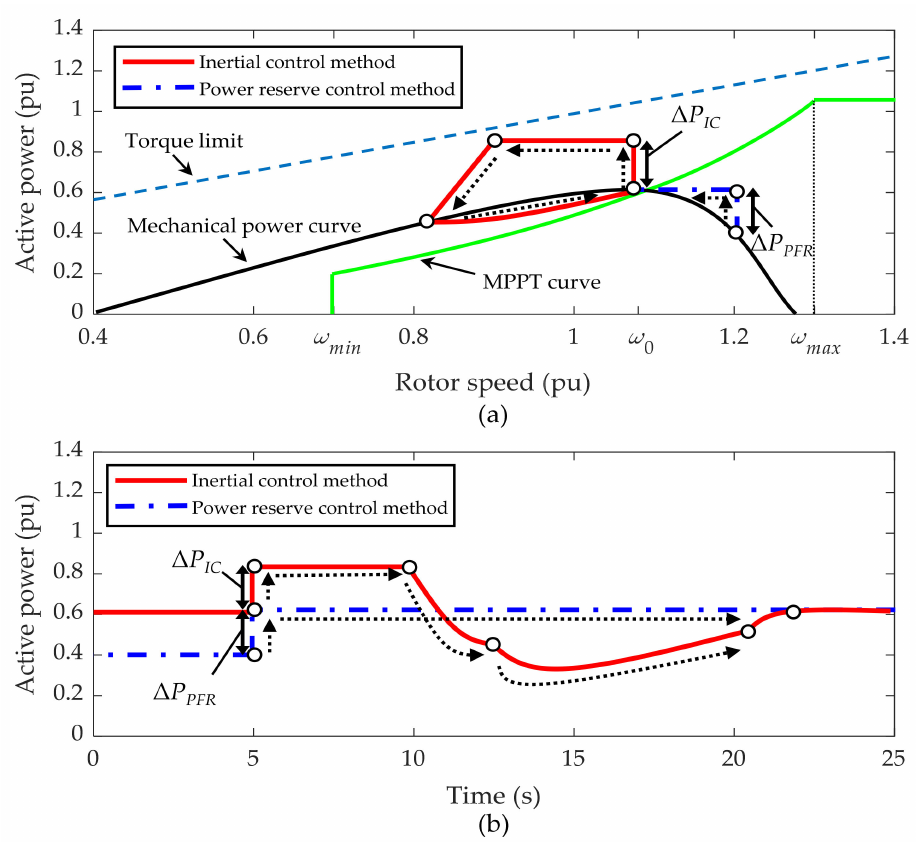
Figure 2. Operational characteristics of inertial control and power reserve control methods. ( a ) Plane of power versus rotor speed and ( b ) time